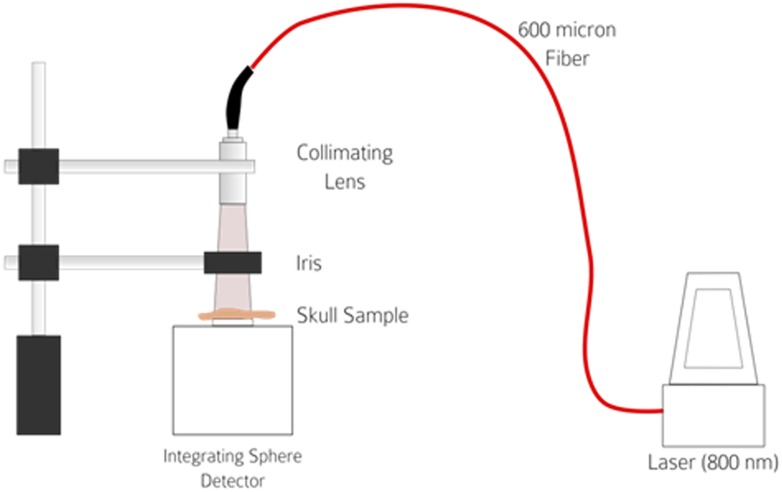
NILT Penetration Physical Set-up.Schematic diagram of the experimental setup used in measuring the light penetration of skulls from various species.